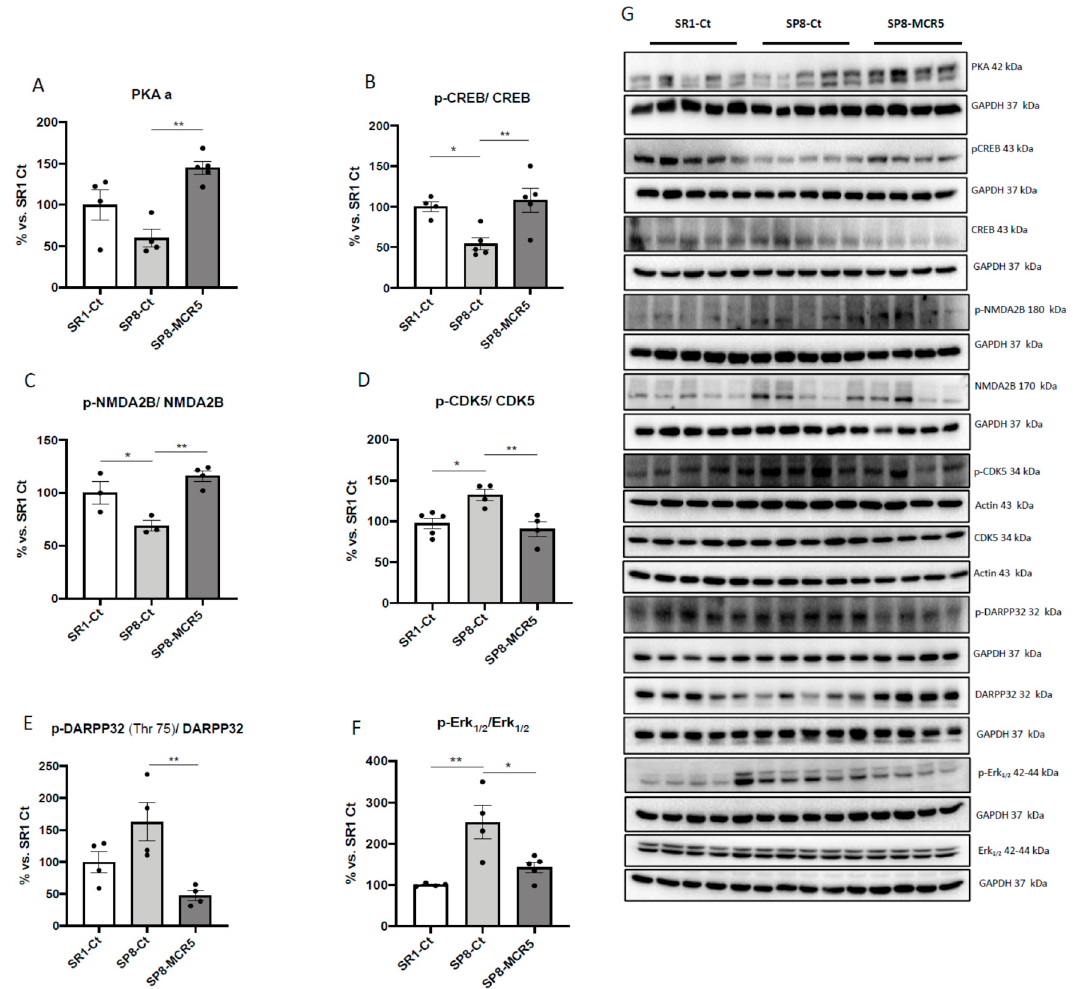
Figure 6. Representative Western blots and quantifications for PKA a, the ratio p-NMDA2B / NMDA2B, ratio p-DARPP32(Thr75) / DARPP32, ratio p-CDK5 / CDK5, ratio p-CREB / CREB and p-Erk 1 / 2 / Erk 1 / 2 ( A – G ). Values in bar graphs are adjusted to 100% for protein levels of the control SAMR1 (SR1-Ct). Values represented are mean ± Standard error of the mean (SEM); ( n = 4–6 for each group). * p < 0.05; ** p < 0.01.